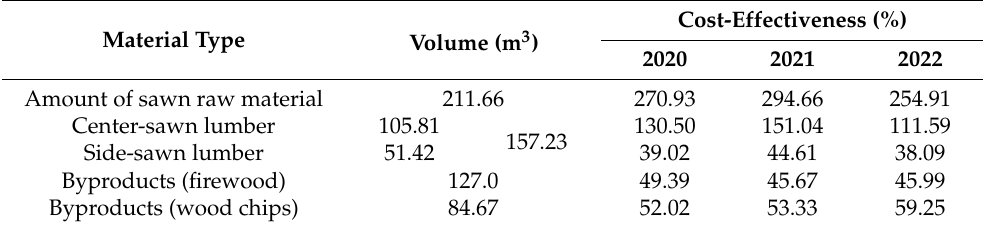
Table 10. Cost-effectiveness ( E p ) of the sawing process according to the variant “B”.